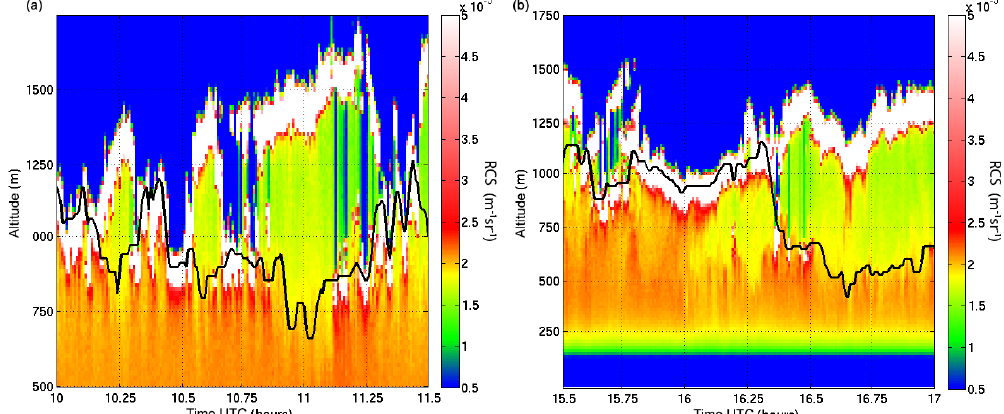
Figure 6. Highlights of the MLH estimate found by the pathfinder algorithm. See text in Sect. 4.2. Shown are (a) difficulties in distinguishing ML and non-ML clouds and (b) commitment to a cloud layer that detaches from the